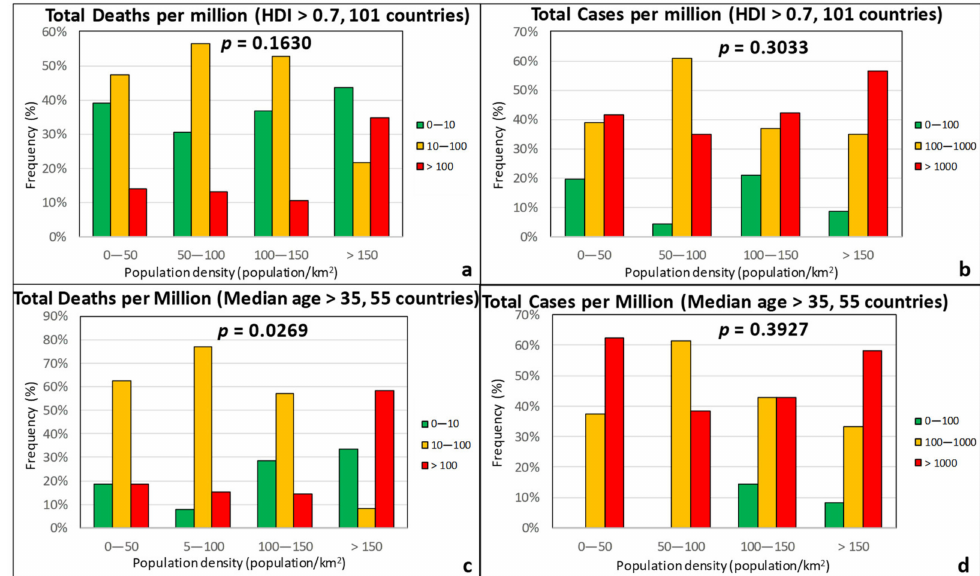
Figure 9. Frequency of total deaths per million (green: low, 0–10; orange: moderate, 10–100; red: high, > 100) and total cases per million (green: low, 0–100; orange: moderate, 100–1000; red: high, > 1000) as a function of the population density for countries with an HDI over 0.7 ( a , b ) and a median age over 35 years ( c , d ).